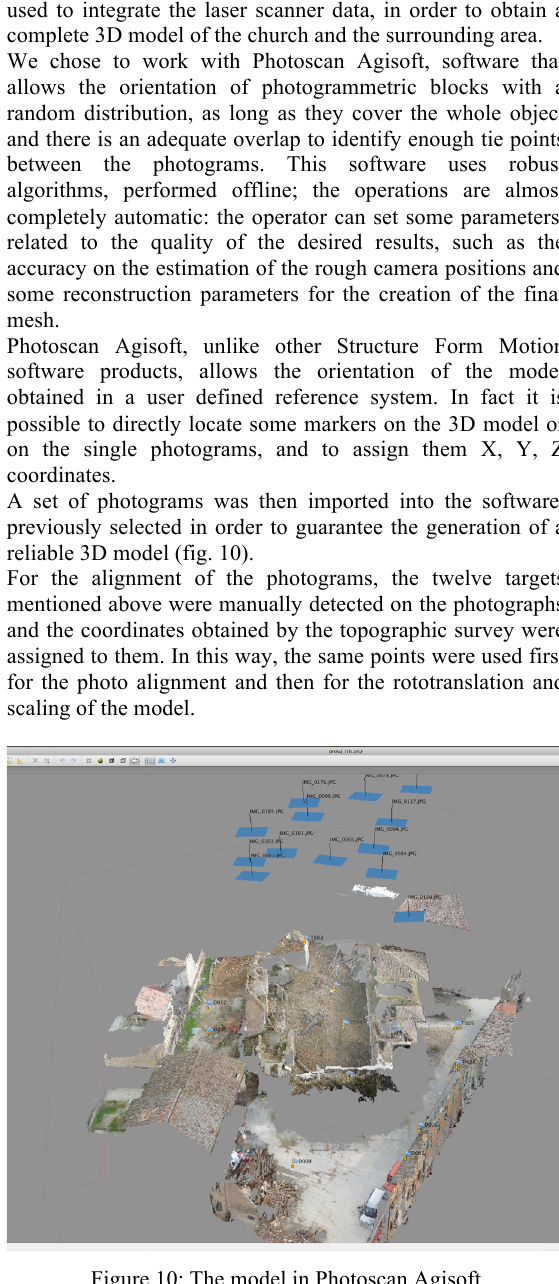
Figure 10: The model in Photoscan Agisoft